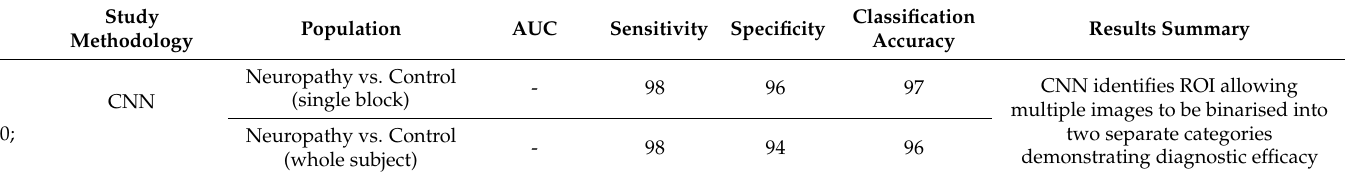
Table 3. Artificial intelligence approaches using corneal confocal microscopy images to classify